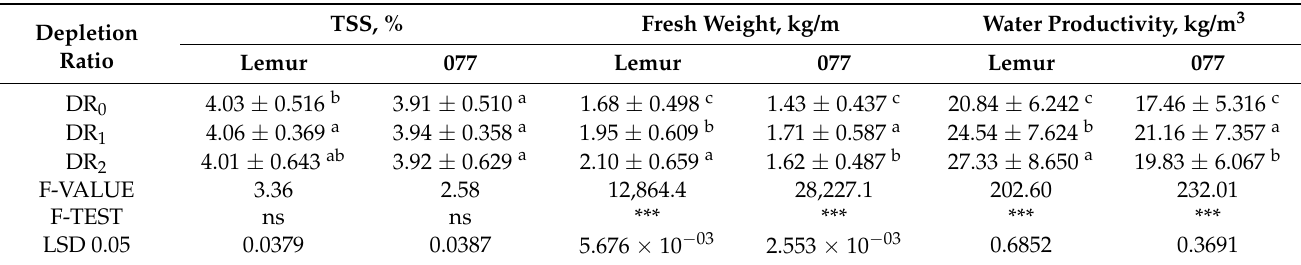
Table 3. Effect of depletion ratio on total soluble solids (TSS), fresh weight (FW) and water productiv- ity ( WP ) of iceberg